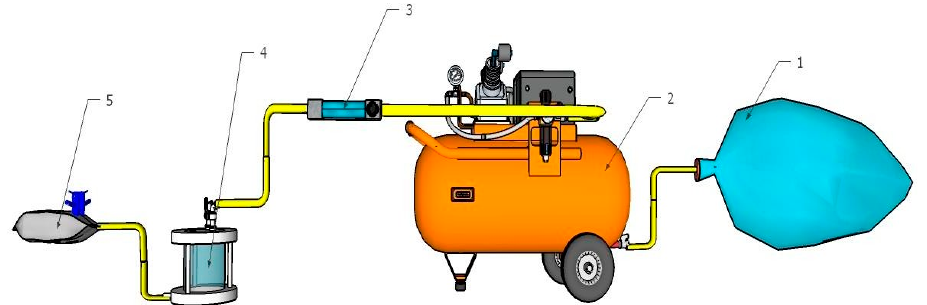
Figure 2. Set-up of biogas purification process.